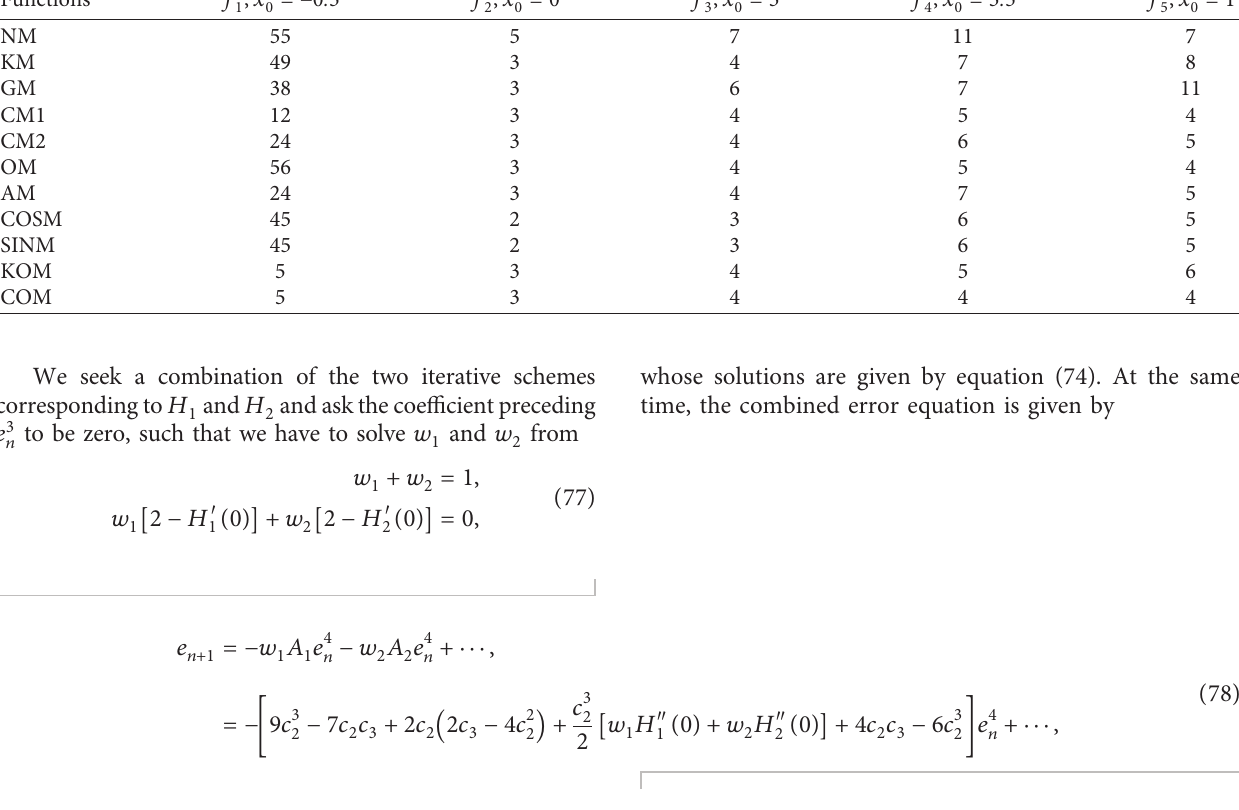
Table 2: The comparison of different methods for the number of iterations.